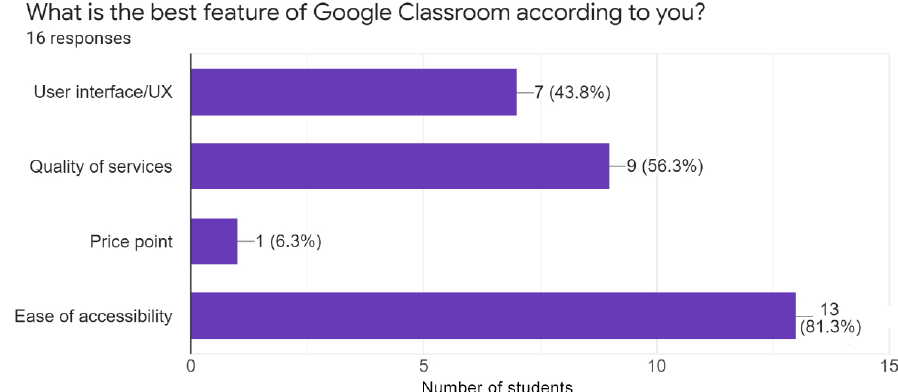
Fig. 4 Best feature of Google Classroom according to the National Institute of Technology, Hamirput students.